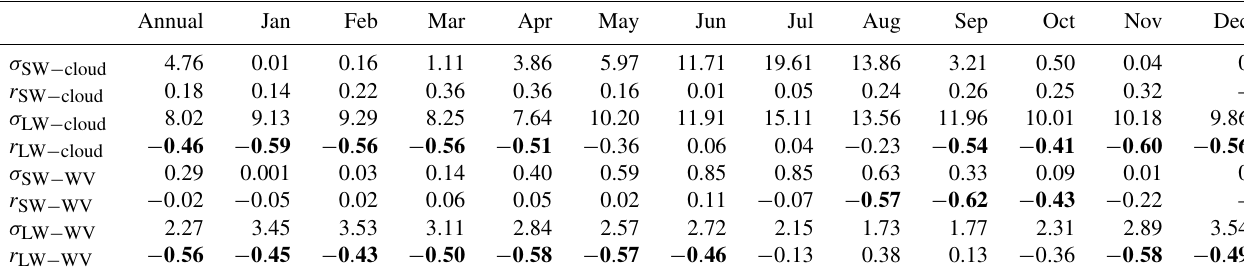
Table 2. The spatial standard deviation of shortwave and longwave radiation anomalies due to cloud change ( σ SW − cloud , σ LW − cloud ) r LW − WV are correlation coefficients between SIC and shortwave and longwave radiation anomalies due to cloud and water change, re- spectively. Those significant at a 99% confidence level are given in bold. Here, the cloud and water vapour change is specified as the part caused by sea ice decrease. Jan